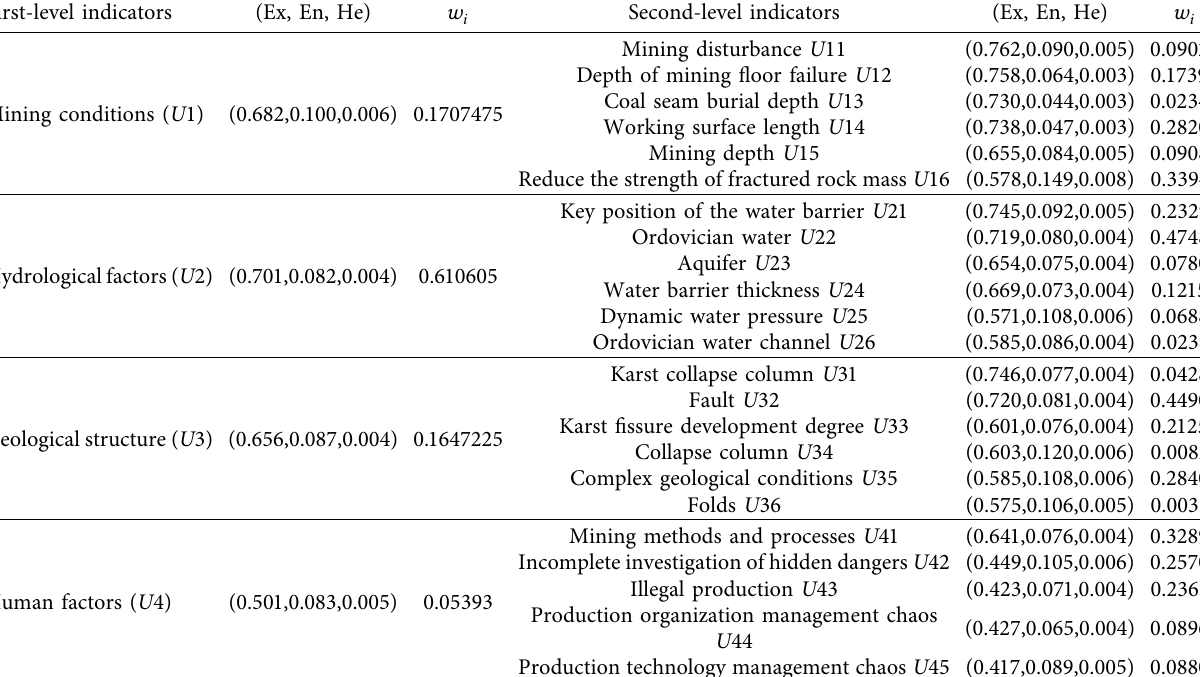
Table 6: Comprehensive characteristic parameters and weights of each index cloud